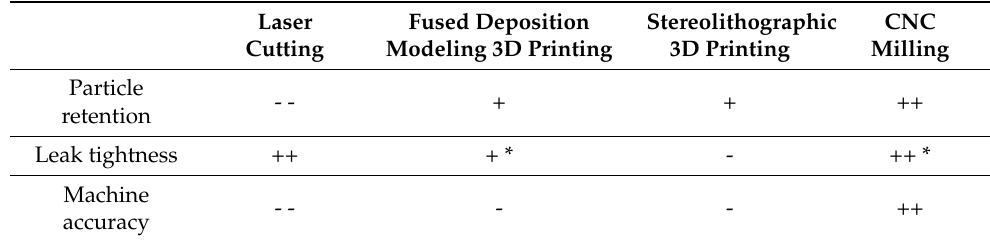
Table 2. Evaluation of fabrication methods for microfluidic chip production. Laser cutting, fused deposition 3D modeling, stereolithographic 3D printing, and CNC milling are compared in regard to particle retention, leak tightness, and structural accuracy of the resulting PDMS chip. Characterized from worst (- -) to best (++). (*)—after acetone